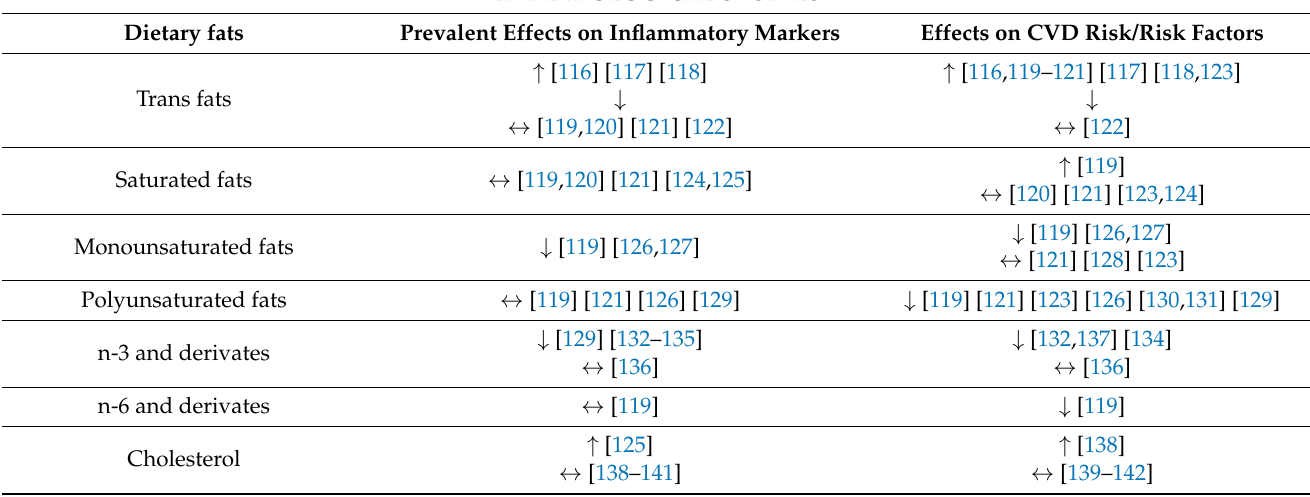
Table 1. Summary of the data from epidemiological studies on the association between dietary intake of fats, circulating markers of systemic inflammation and risk of CVD. ↑ : Indicates data showing a positive association between the dietary fat intake and the outcome (either inflammatory markers or CVD risk factors); ↓ indicates data showing a positive association between the dietary fat intake and the outcome (either inflammatory markers or CVD risk factors). ↔ indicates that there are missing or contrasting data regarding association between the dietary fat intake and the outcome (either inflammatory markers or CVD risk